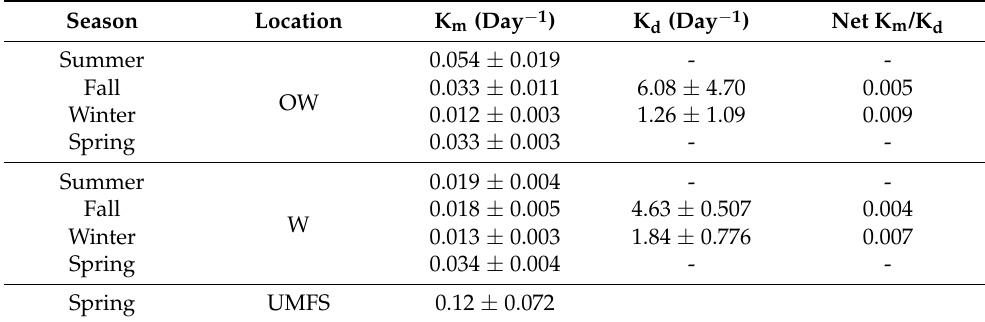
Table 3. Sediment Hg methylation (K m ) and MeHg demethylation (K d ) rates for sediment in Sky Lake (open water and wetland areas) and the University of Mississippi’s Biological Field Station ( n = 3; ± 1 SD) n , bulk samples of the same sediment.